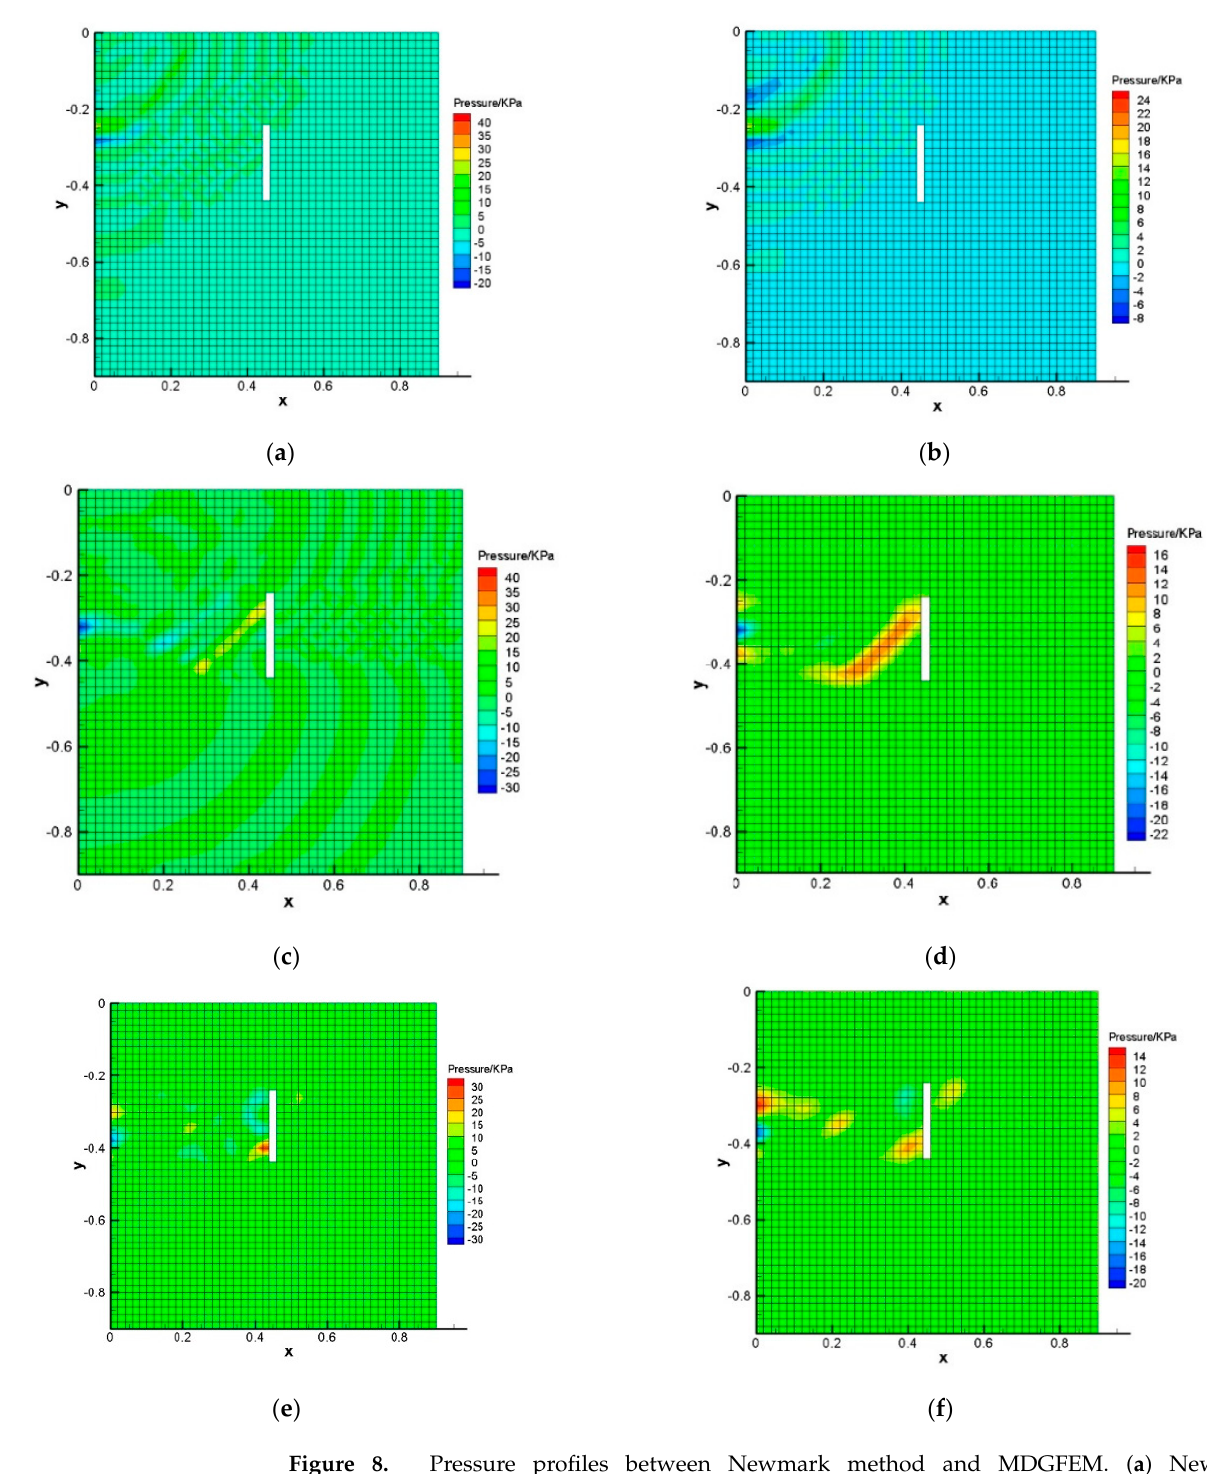
Figure 7. Elastic stress profiles between Newmark method and MDGFEM. ( a ) Newmark 0.15 μs ; ( b ) MDGFEM 0.15 μs ; ( c ) Newmark 0.3 μs ; ( d ) MDGFEM 0.3 μs ; ( e ) Newmark 0.45 μs ; and ( f ) MDGFEM 0.45 μs .